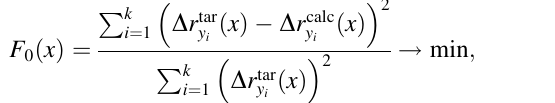
Fig. 2 Fixed and movable points on wheel